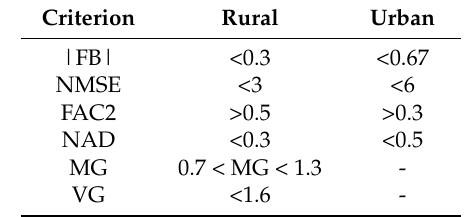
Table 3. Statistical metrics for prediction from UDM compared against data for Prairie Grass release 49.